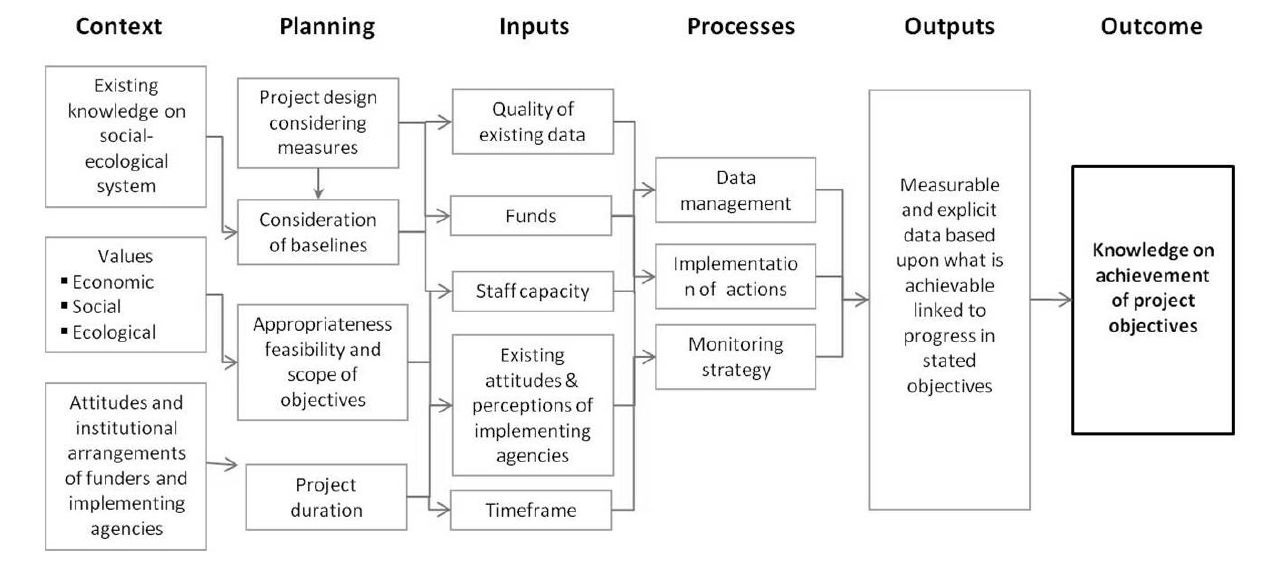
Fig. 3. Conceptual model illustrating how different components, within the natural resource management system in Samoa, contribute to informative evaluation of conservation